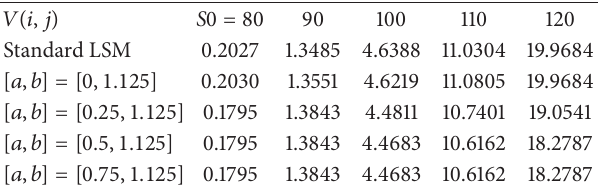
Table 8: Numerical result for Example 5.